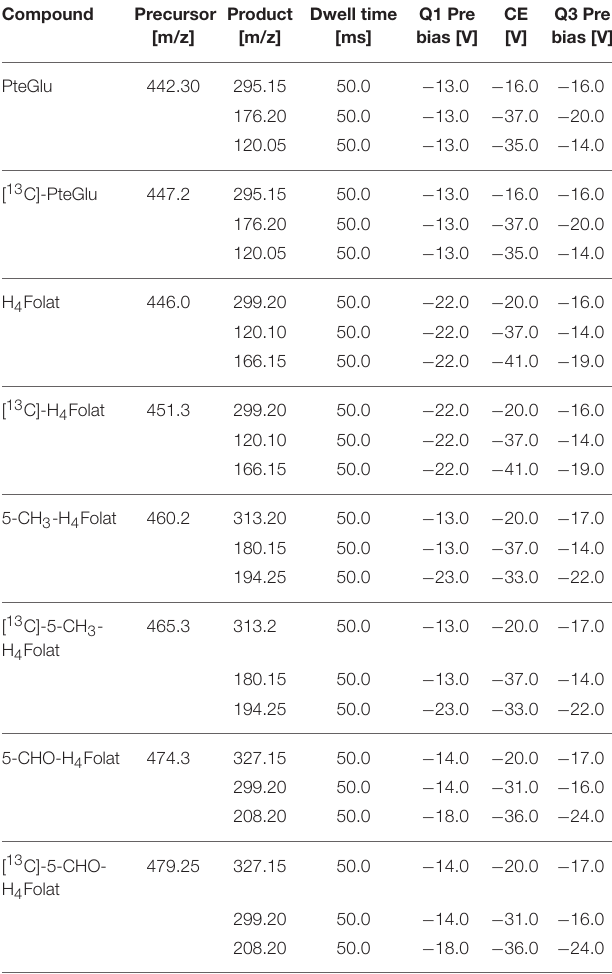
TABLE 1 | MRM scan parameters for PteGlu, H 4 folate, 5-CH 3 -H 4 folate, 5-CHO-H 4 folate, and the respective internal